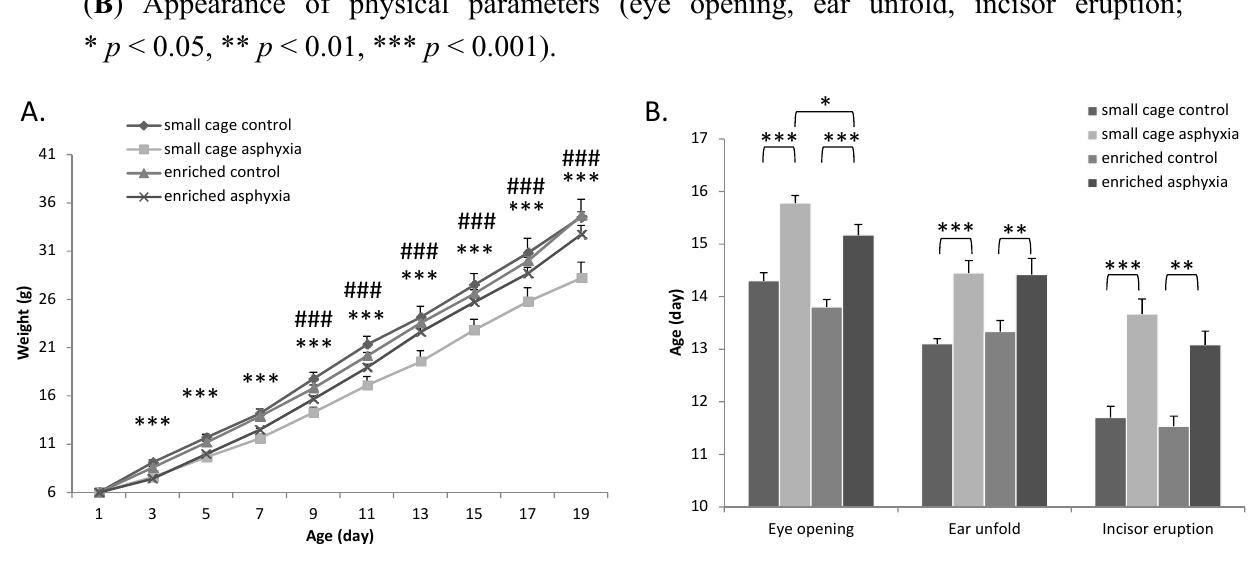
Figure 1. ( A ) Daily changes in body weight (*** p < 0.001 small cage control vs. small cage asphyctic group; ### p < 0.001 small cage asphyctic vs. enriched asphyctic group); and ( B ) Appearance of physical parameters (eye opening, ear unfold, incisor eruption; * p < 0.05, ** p < 0.01, *** p <